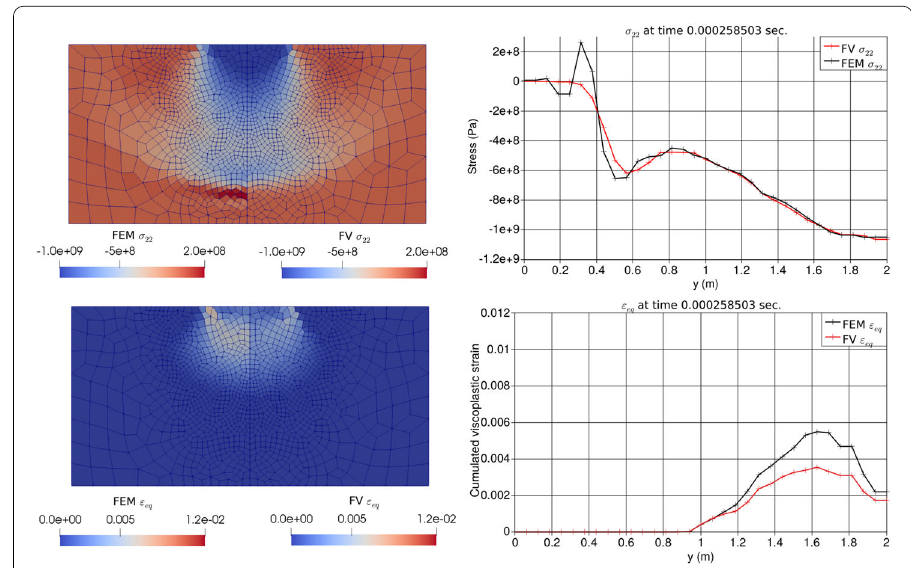
Fig. 12 Normal stress σ 22 and cumulated viscoplastic strains ε eq ≡ p at time 2 . 58 × 10 − 4 s, computed with finite elements (left-half domain) and finite volumes (right-half domain). Superposed plots are made along the symmetry line (Additional file 1)